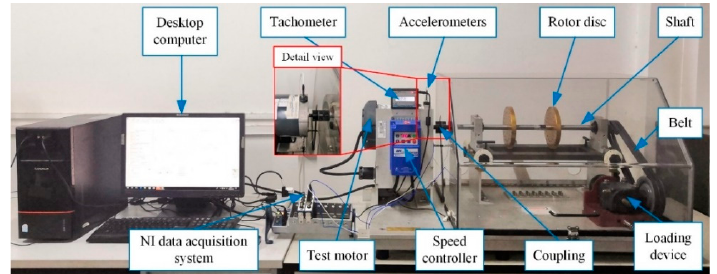
Figure 5. Experimental setup of the bearing failure bench.